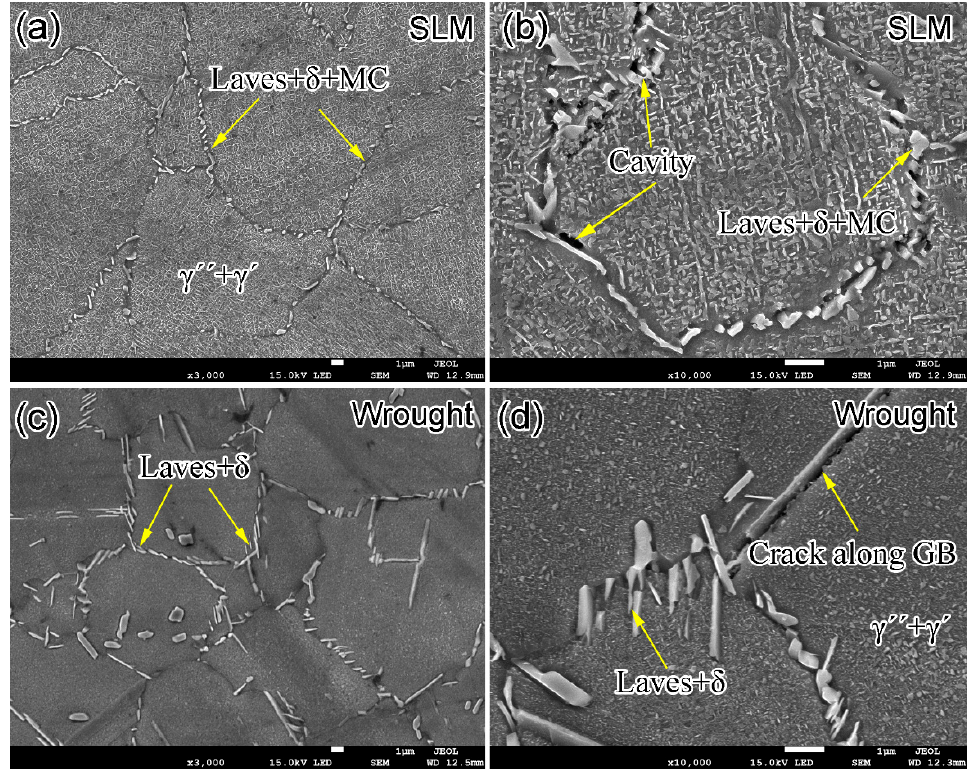
Figure 9. SEM images showing microstructure and microcracks of ( a , b ) SLM IN718 run-out specimen ( σ a = 411 MPa, N f = 1 × 10 9 ) and ( c , d ) the wrought run-out specimen ( σ a = 421 MPa, N f = 1 × 10 9 ) after fatigue tests at 650 °C. The examined surfaces are located in the middle of the samples and are perpendicular to the loading direction.